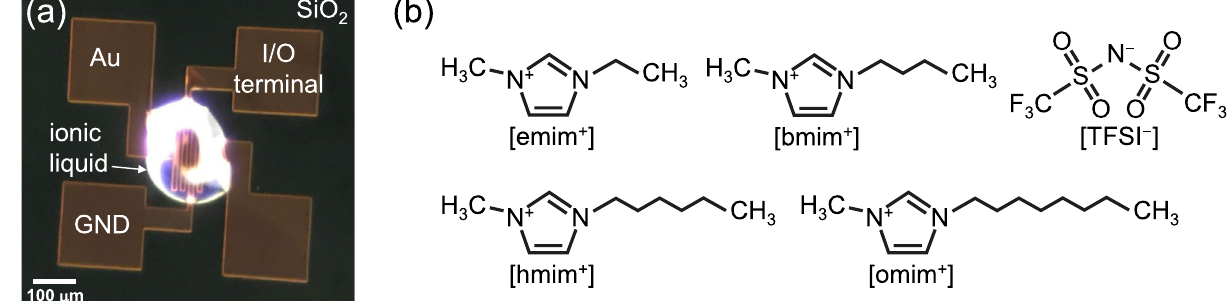
Figure 1. ( a ) Optical micrograph of Au/IL/Au reservoir device fabricated by dropping ILs onto Au gap electrode patterned on the SiO 2 surface layer of Si substrate. ( b ) Structural formulas of emim + , bmim + , hmim + , and omim + cations (left-hand side) and TFSI − anion (right-hand side) in [Rmim + ][TFSI −